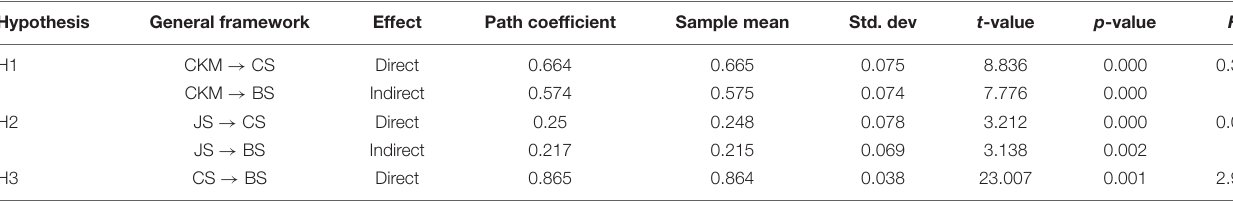
TABLE 4 | General model resolution using the PLS algorithm and Bootstrapping. Hypothesis General framework